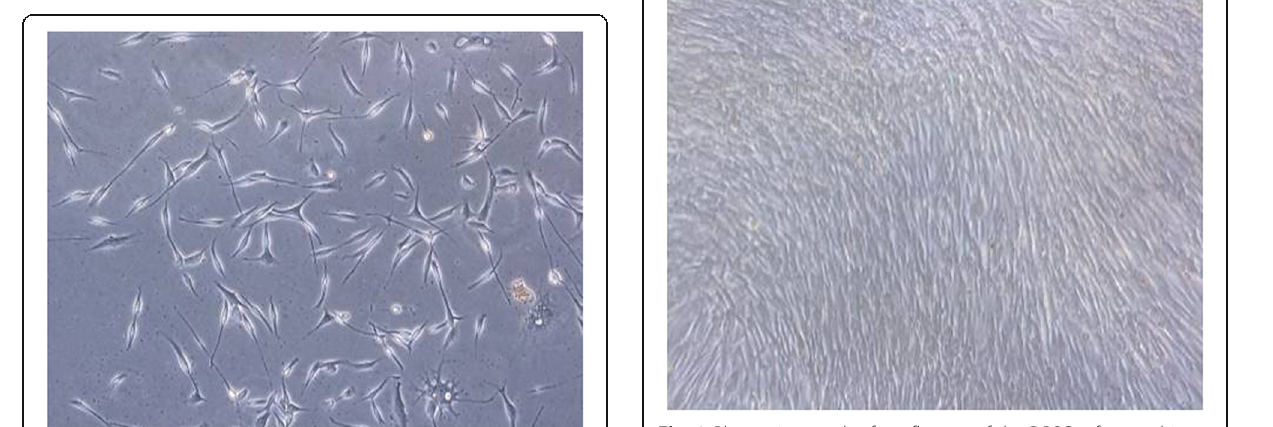
Fig. 3 Photomicrograph of confluence of the DPSCs after reaching confluence, cells illustrate compressed appearance due to increase in number (magnification ×